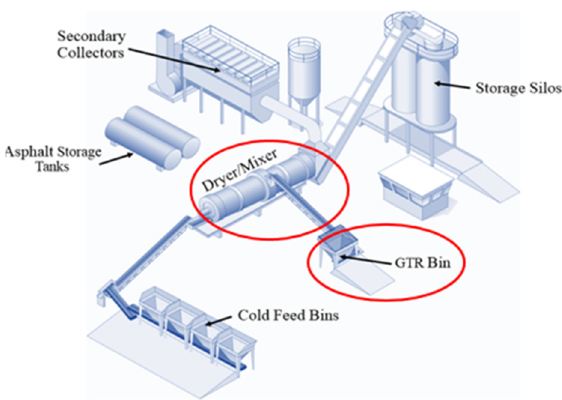
Figure 3. Demonstration project in Dickinson (Revised from Mamlouk [21]).